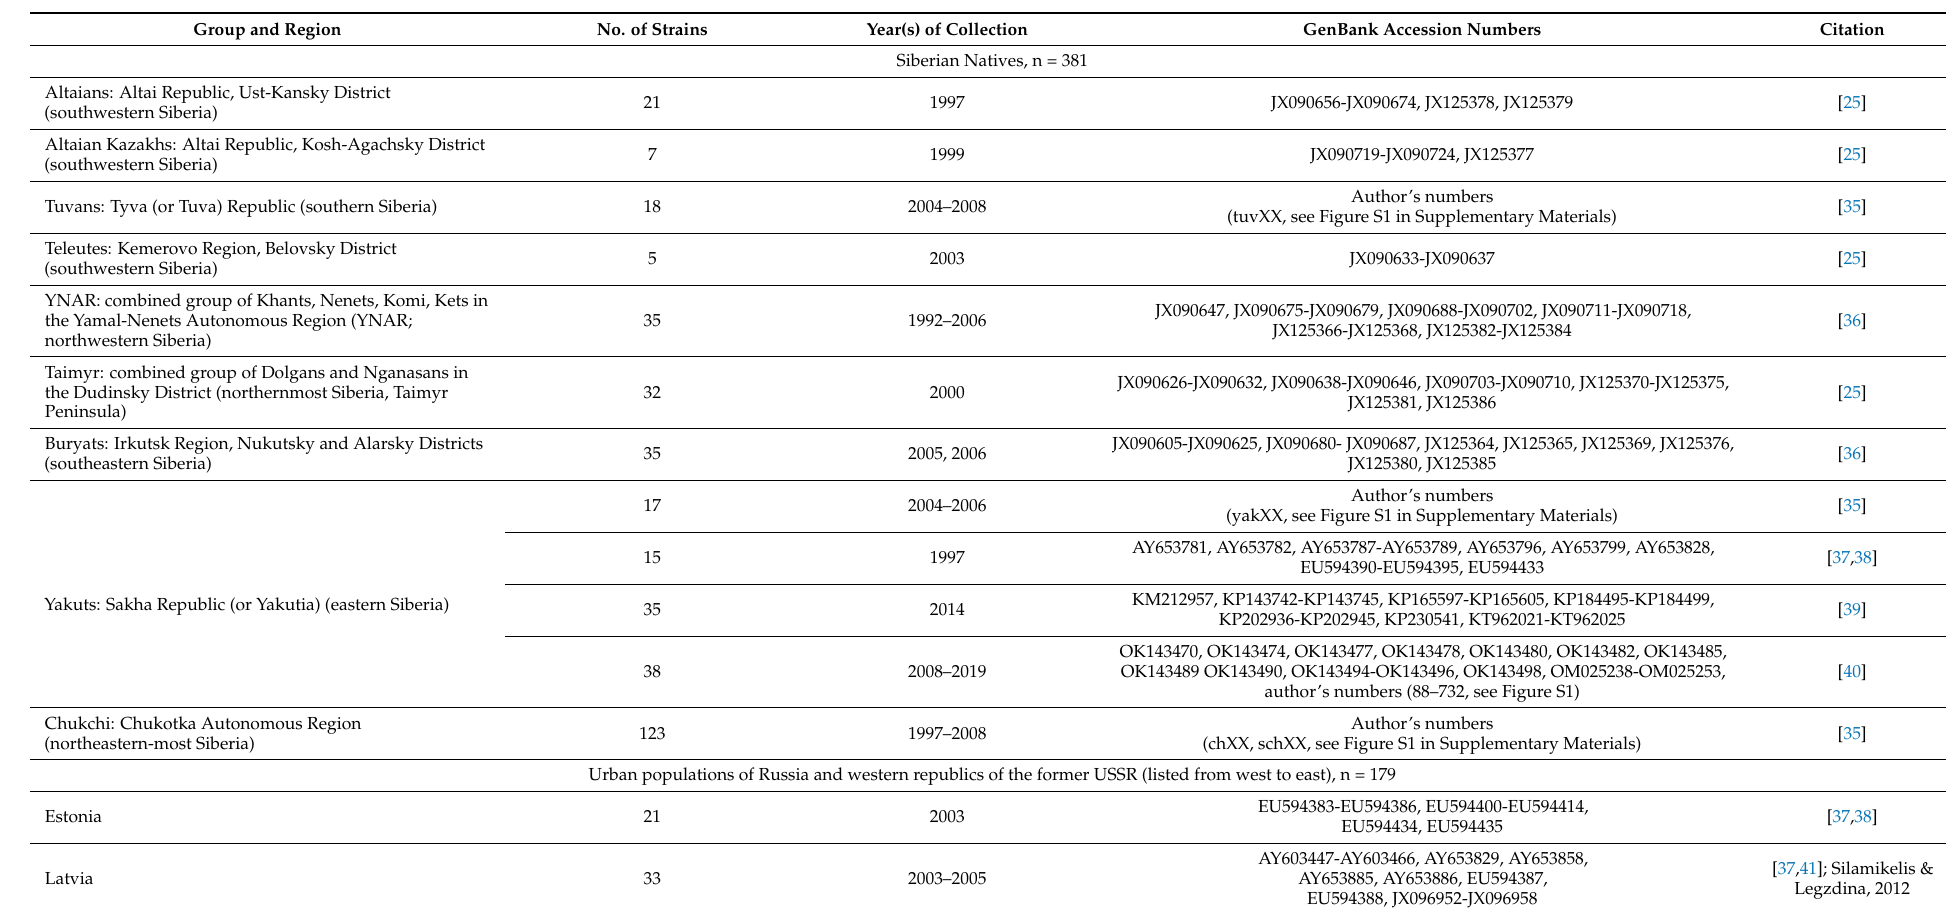
Table 1. List of the HBV strains included in the study (n =